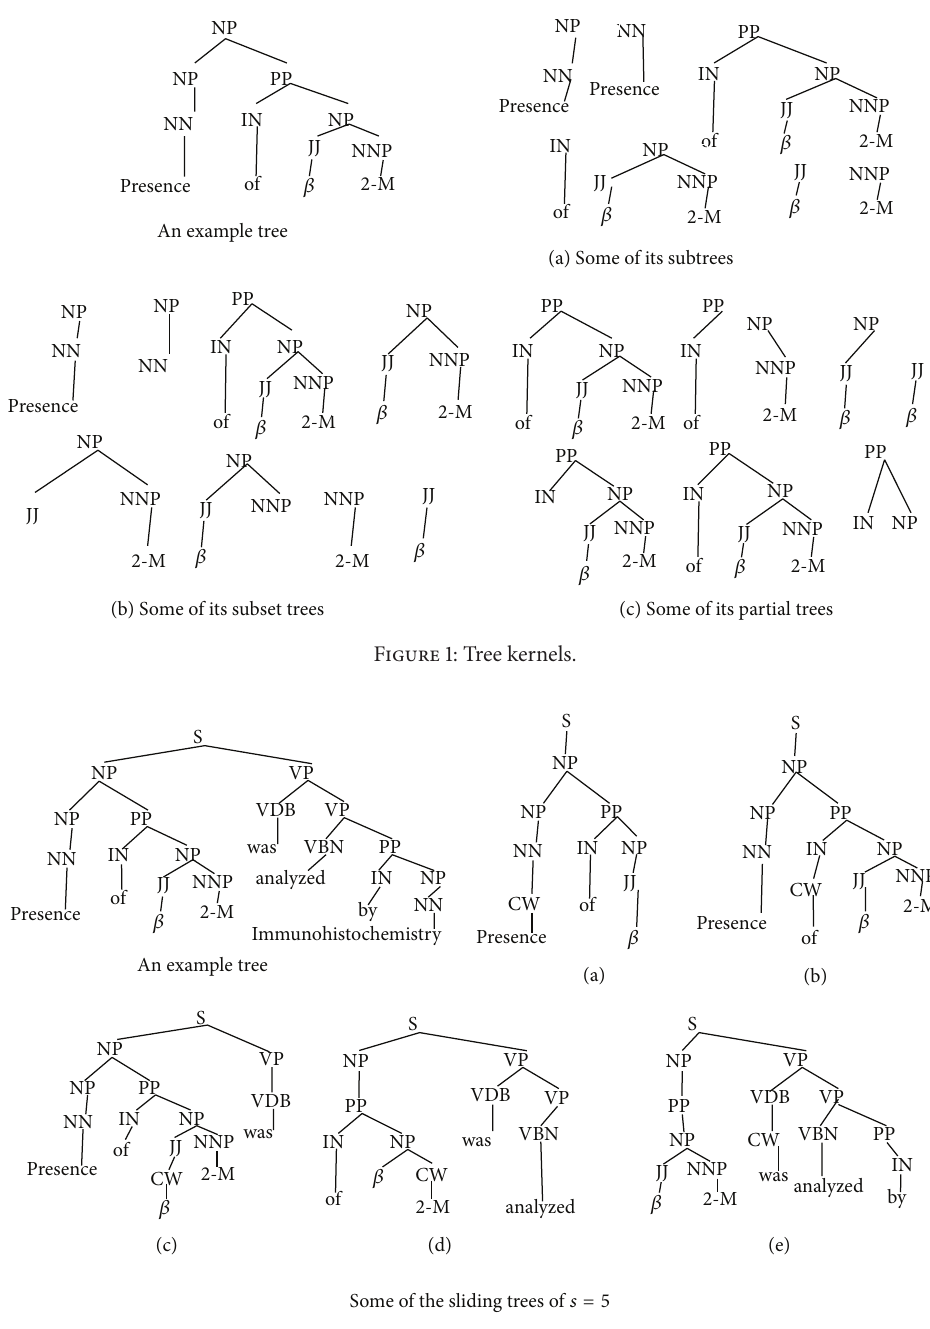
Figure 1: Tree kernels.